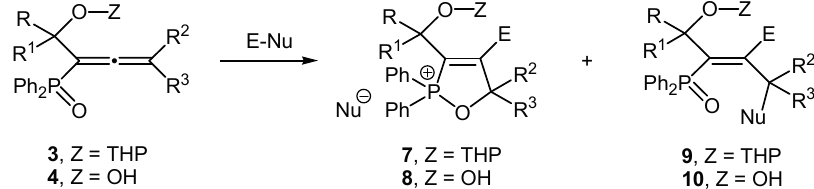
Table 3. Synthesis of the 2,2-diphenyl-2,5-dihydro-1,2-oxaphosphol-2-ium halides 7 and